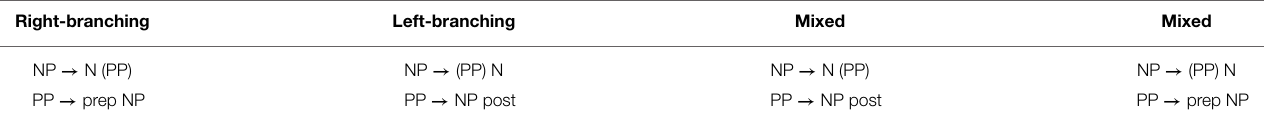
TABLE 2 | Recursive rule